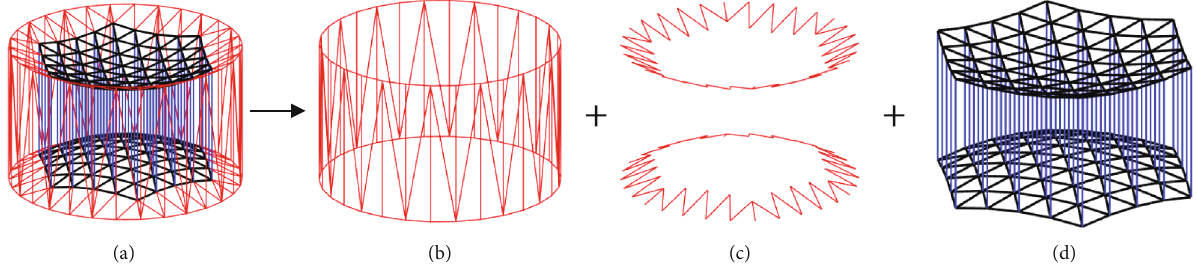
Figure 3: Composition of a mesh re fl ector. (a) Mesh re fl ector. (b) Truss. (c) Boundary cable. (d) Cable net.